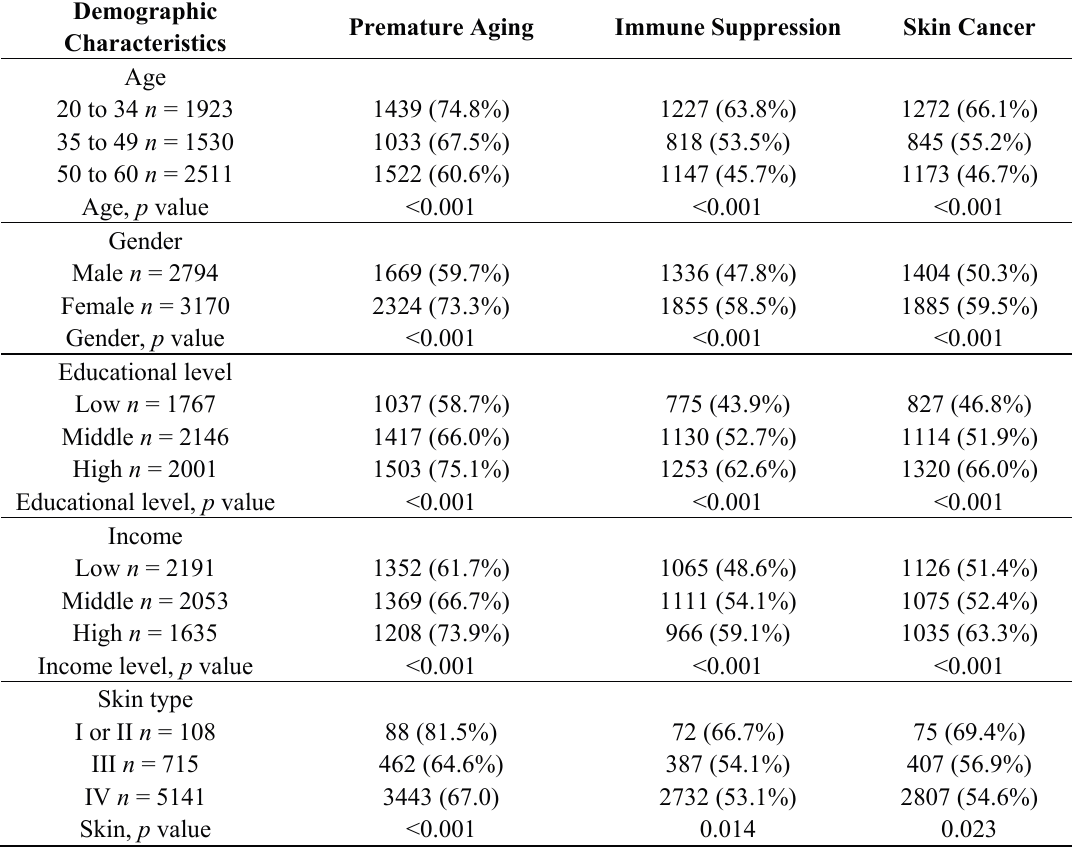
Table 3. Knowledge about the UV-induced risk of the 5964 responders, stratified by age, gender, education level and income